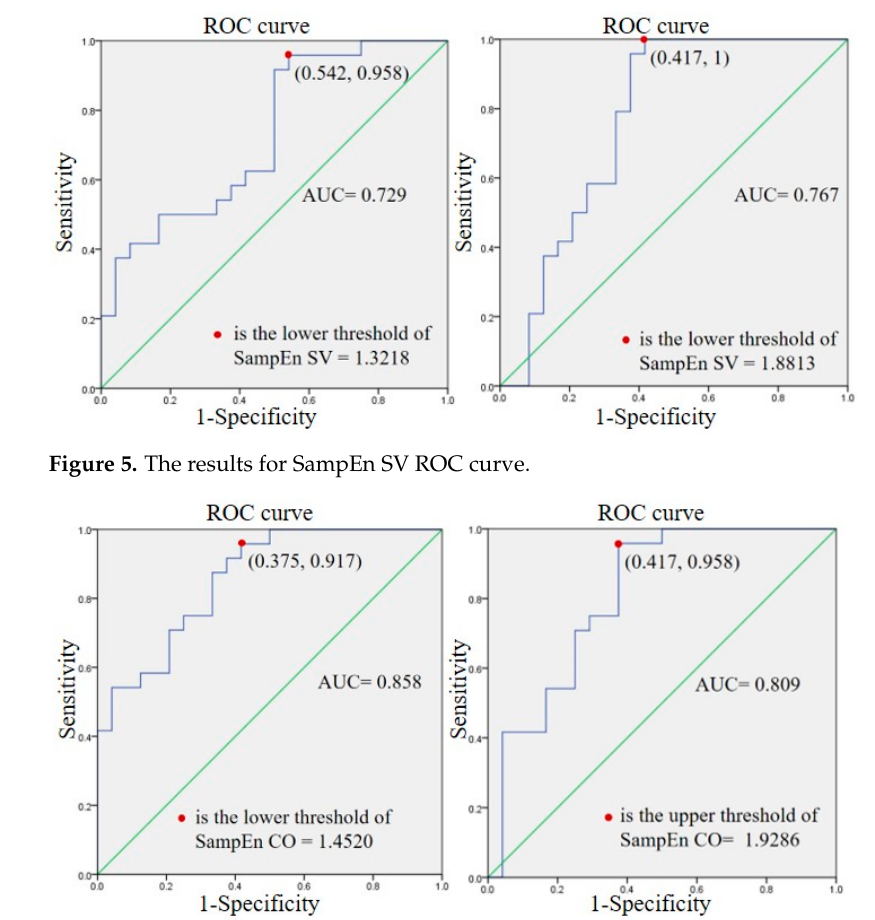
Figure 4. The results for SampEn RR ROC curve.